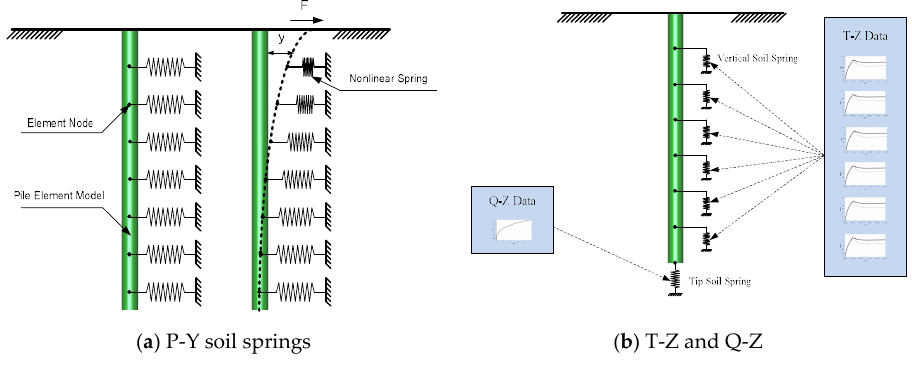
Figure 3. Soil-pile interaction model.